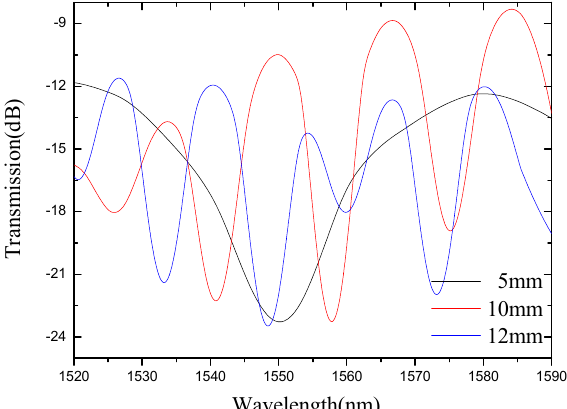
Figure 3. Interferometric spectra of sensors with different lengths.